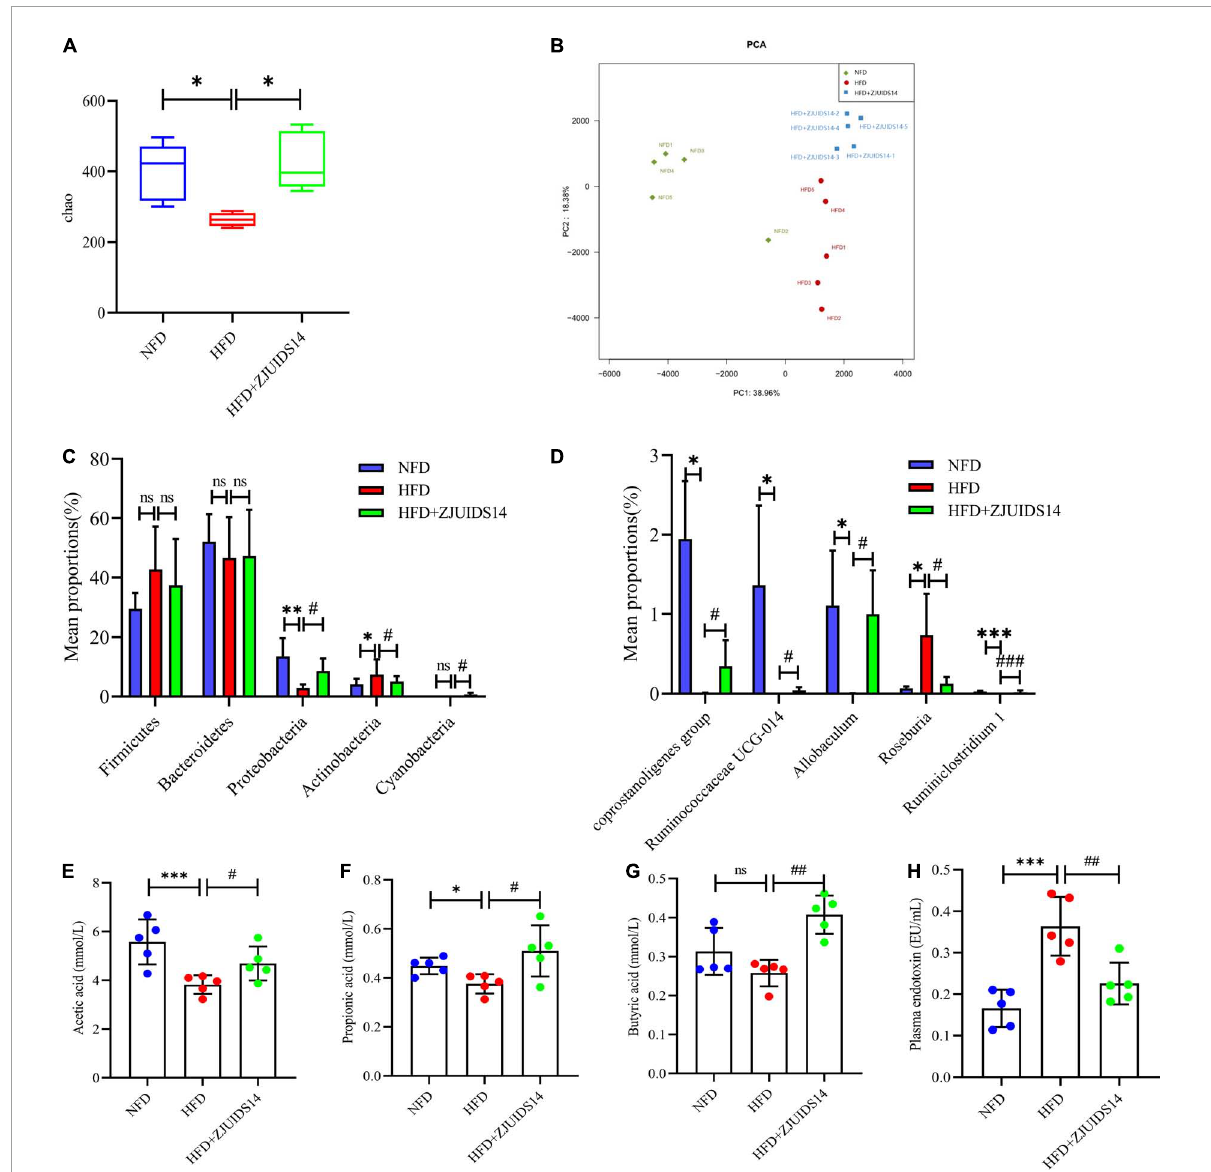
FIGURE7 Lactobacillus plantarum ZJUIDS14 administration prevents gut microbiota dysbiosis in HFD fed mice. (A) Alpha diversity using Chao richness. (B) Principal coordinate analysis. Different fecal microbiota profiles shown at phylum (C) and genus (D) level. Intestinal contents of (E) acetic acid, (F) propionic acid, (G) butyric acid. (H) Plasma endotoxin. ∗ P < 0.05, ∗∗ P < 0.01, ∗∗∗ P < 0.001 vs NFD group; # P < 0.05, ## P < 0.01, ### P < 0.001 vs HFD group. ns, not